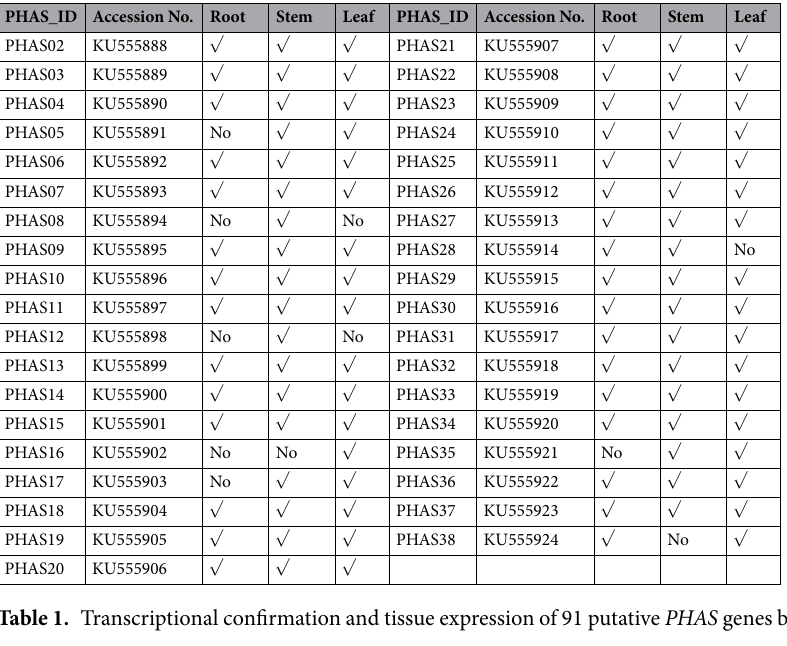
4 Scientific RepoRts | 7: 3019 | DOI:10.1038/s41598-017-02233-x